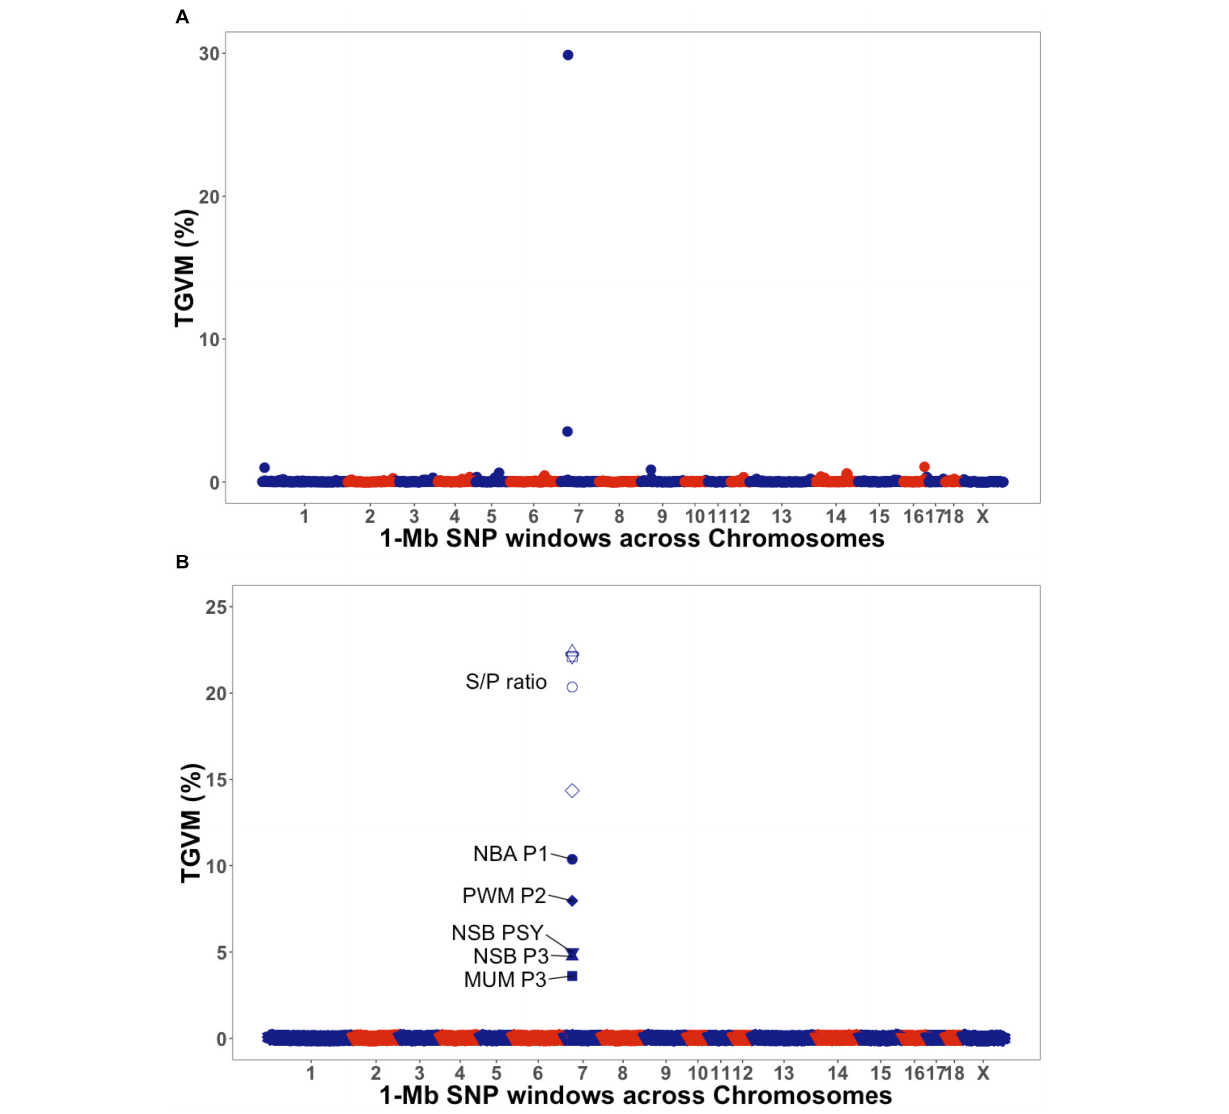
region defined by training population without CG 3. The TGVM 26.06% (PPI = 1.00; CGs 2 and 3 in the training dataset), 23.94%